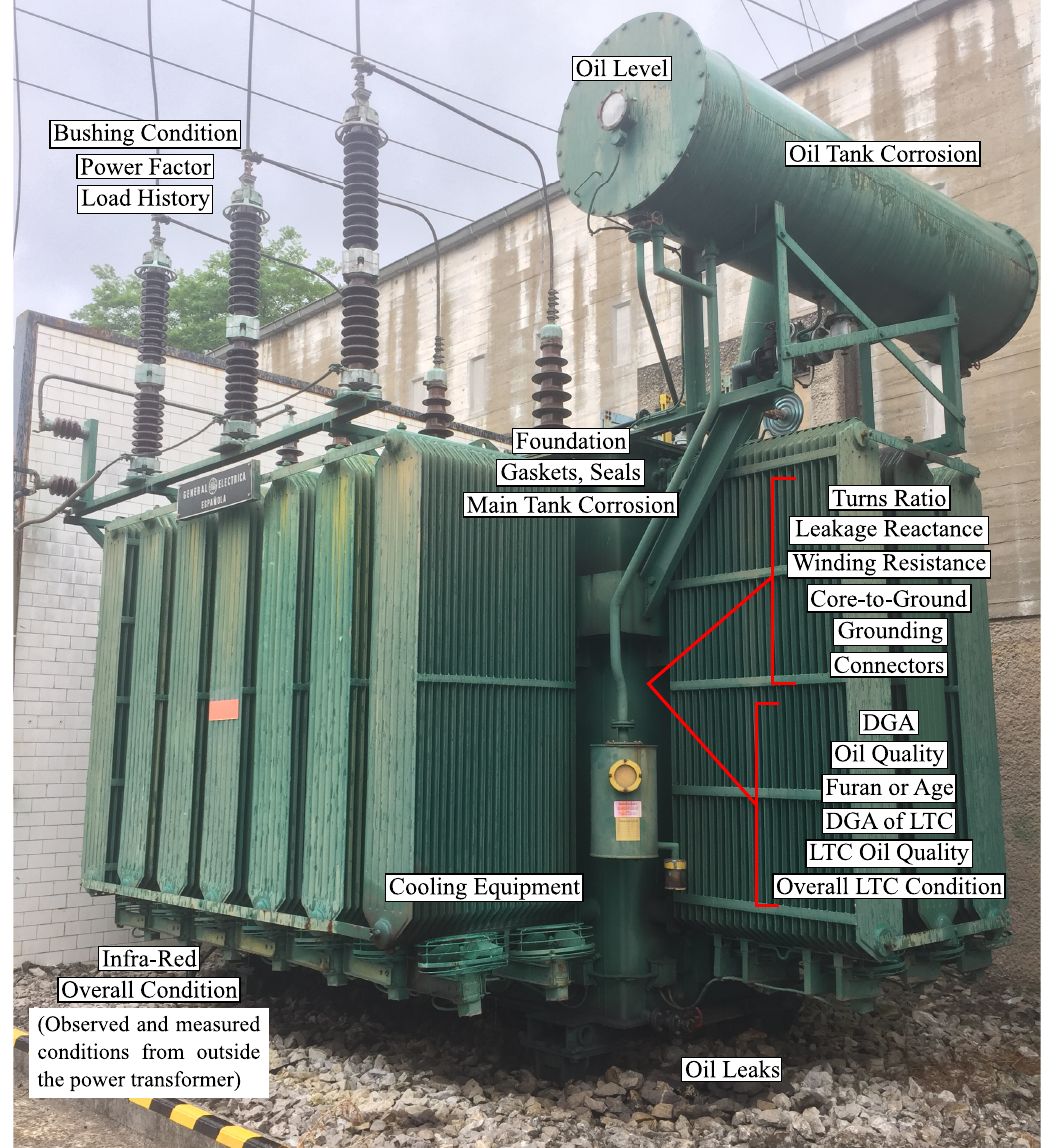
Figure 2. Location of the parameters measured for the HI calculation of the